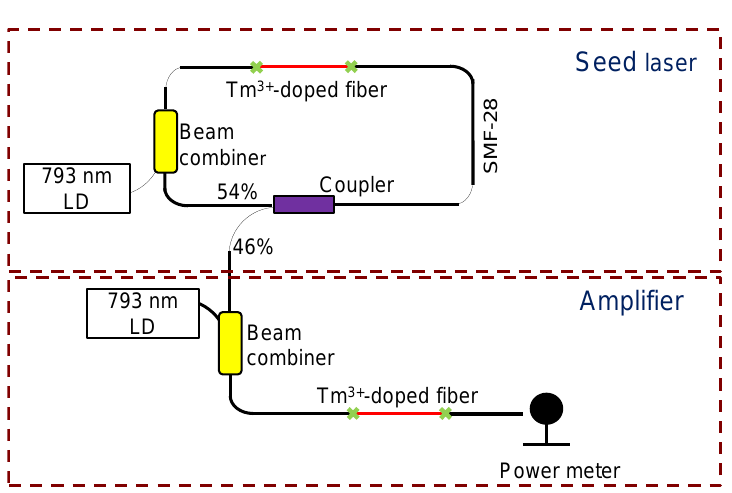
Figure 5. Experimental Tm 3+ -doped silicate fiber